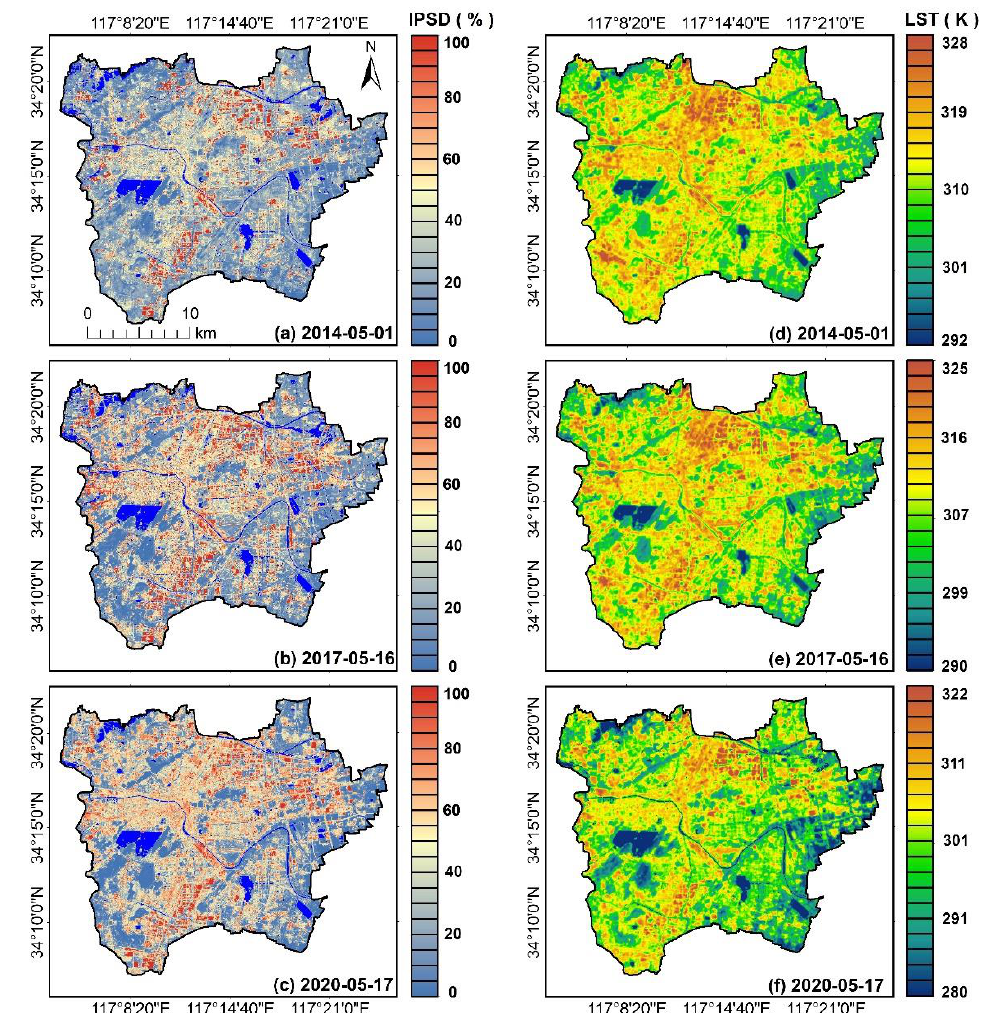
Figure 5. Inversion images of impervious surface density (ISPD) (left ( a – c )) and land surface temperature (LST) (right ( d – f )). Table 4. Regression results between IPSD and LST by applying four